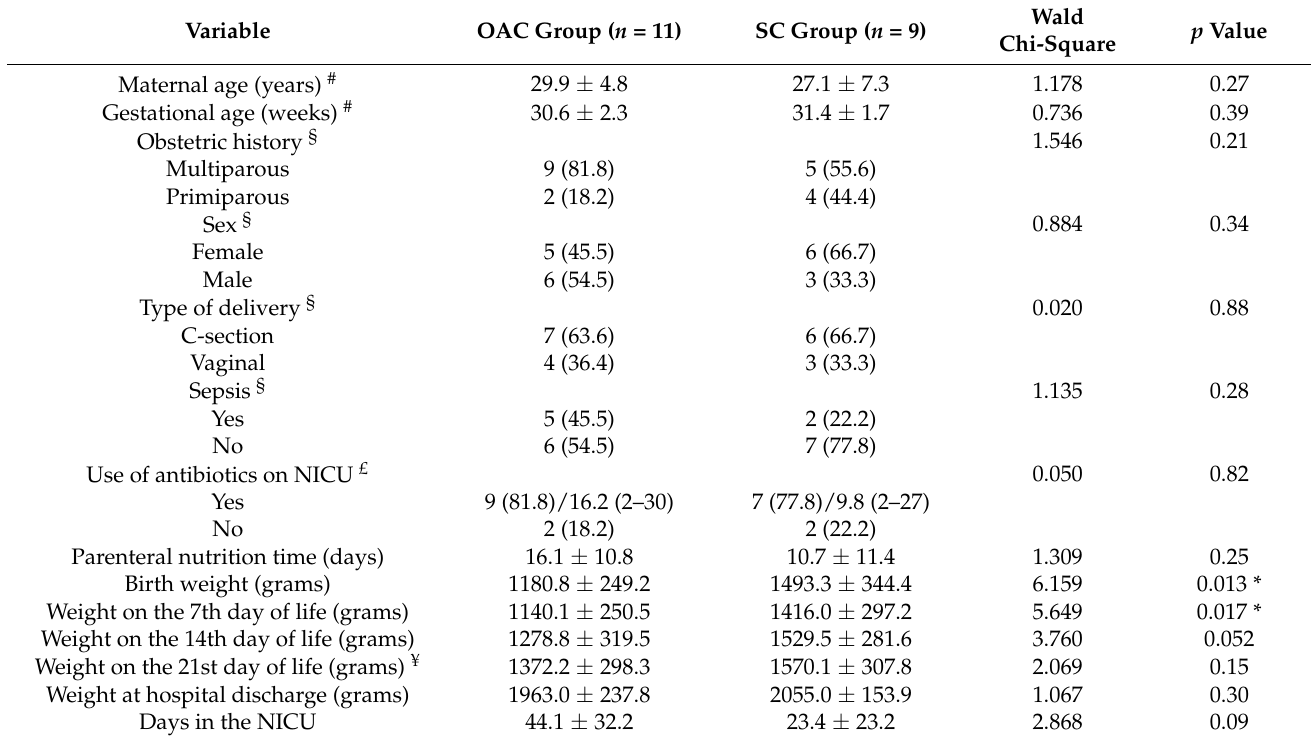
Table 1. Comparison of descriptive and clinical data between groups ( n =